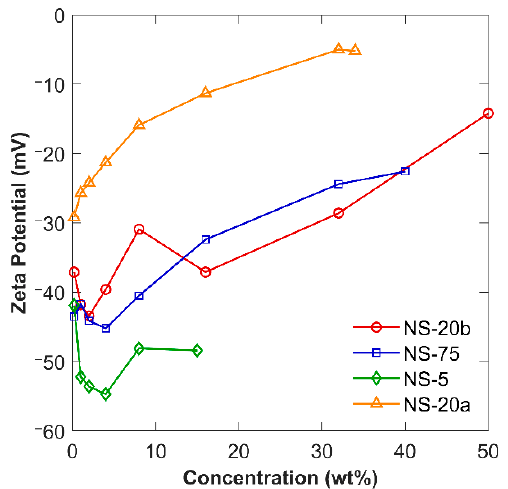
Figure 5. Zeta potential of NS sols through a range of dilution.